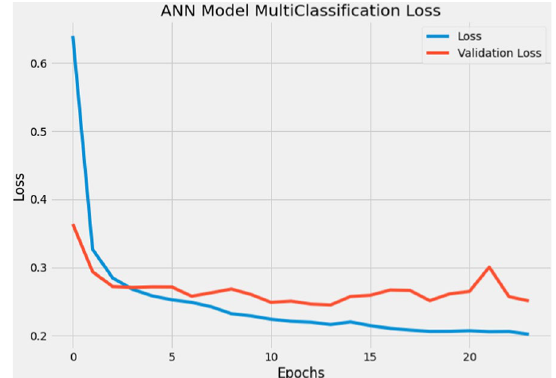
Fig. 10 Training and validation loss of LSTM